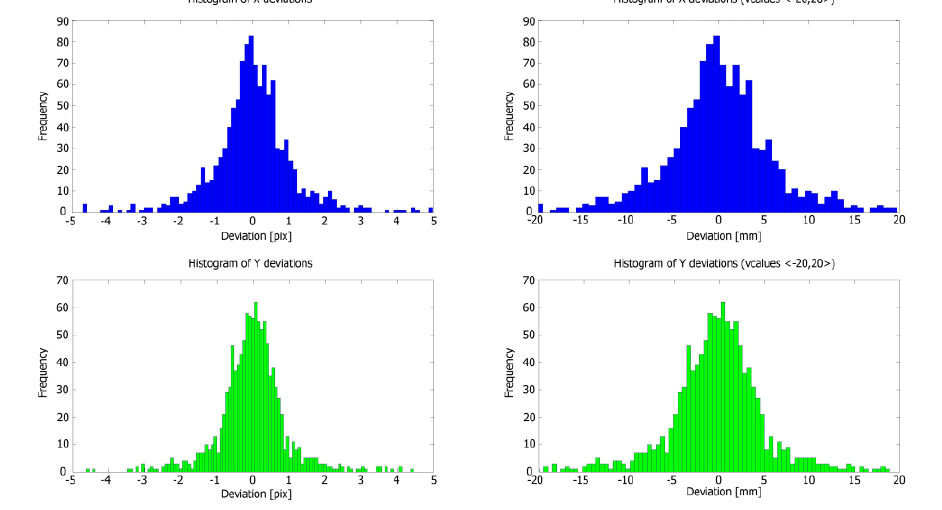
Fig. 12 Histograms of control points deviations (Image 1): A) X direction in pixels (blue), B) Y direction in pixels